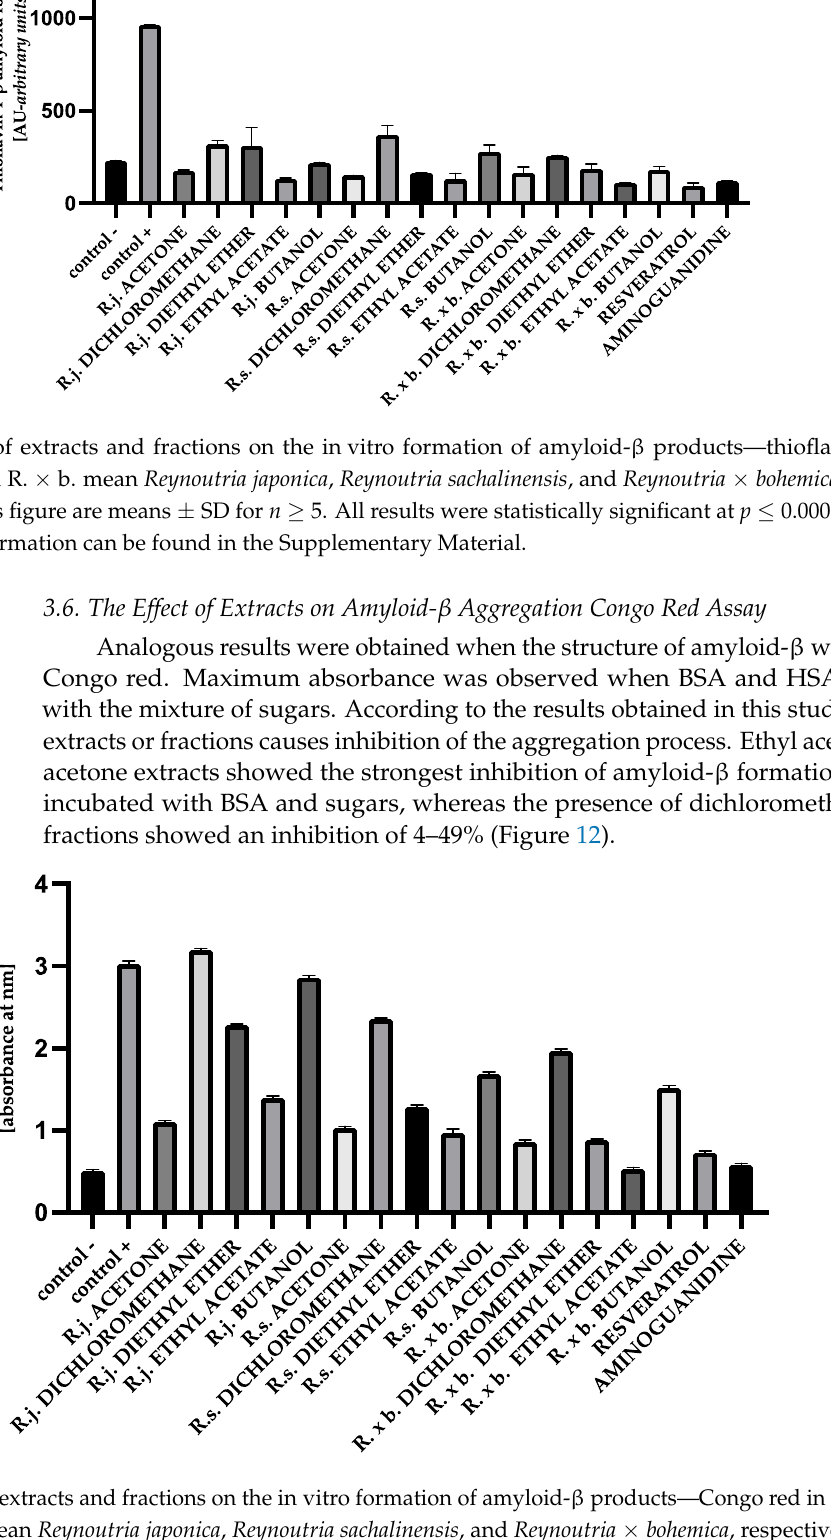
14 of 26 Figure 10. The effect of extracts and fractions on the in vitro formation of amyloid- β products—thioflavin T in BSA gly- cation. R.j., R.s., and R. × b. mean Reynoutria japonica , Reynoutria sachalinensis , and Reynoutria × bohemica , respectively. Error